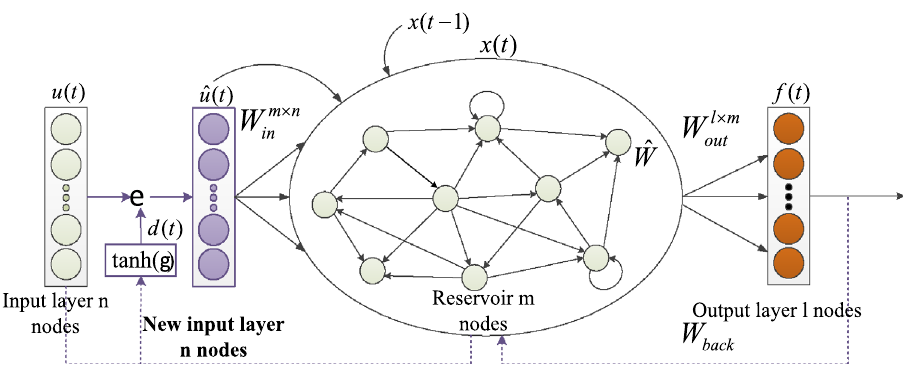
Figure 3. The structure of the